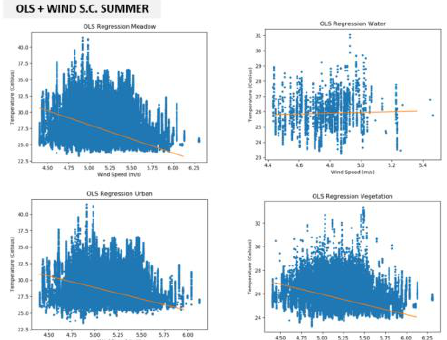
Figure 24: OLS Regression Model in Summer (Temperature – Land Cover - Wind)